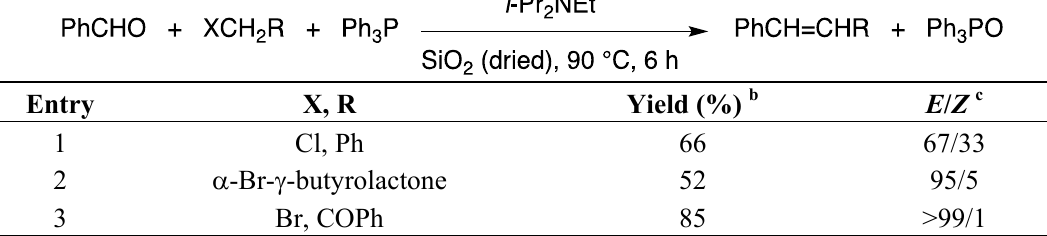
Table 6. One-pot olefination of benzaldehyde with various halides on silica gel a .